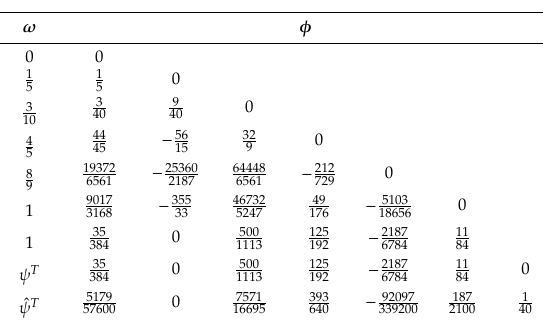
Table 3. Butcher array for